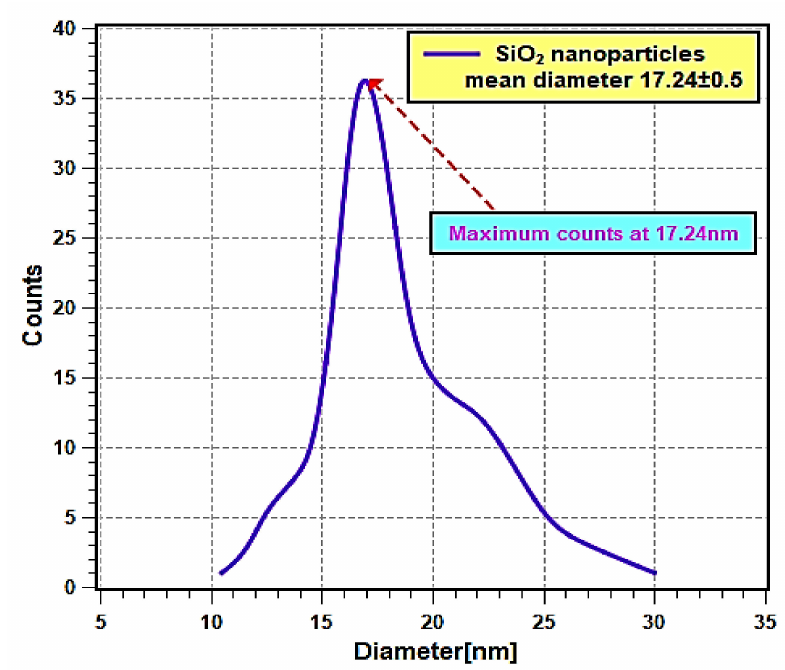
Figure 4. Nanoparticles mean diameter distribution curve.